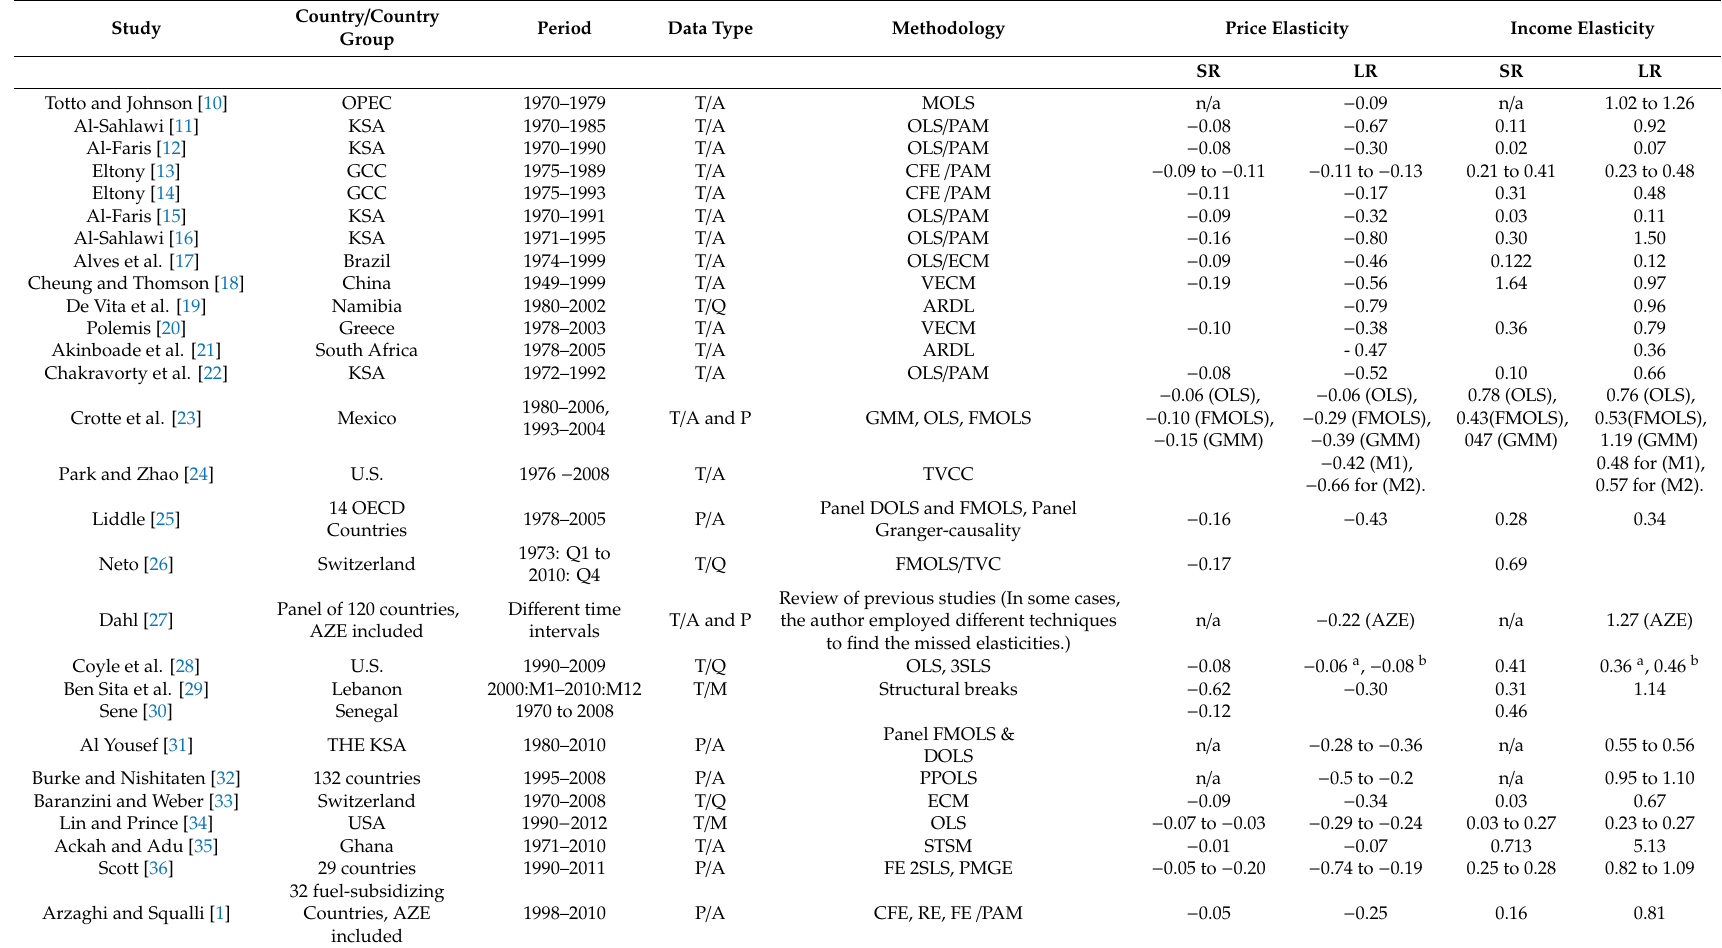
Table 1. Summary of the relatively recent